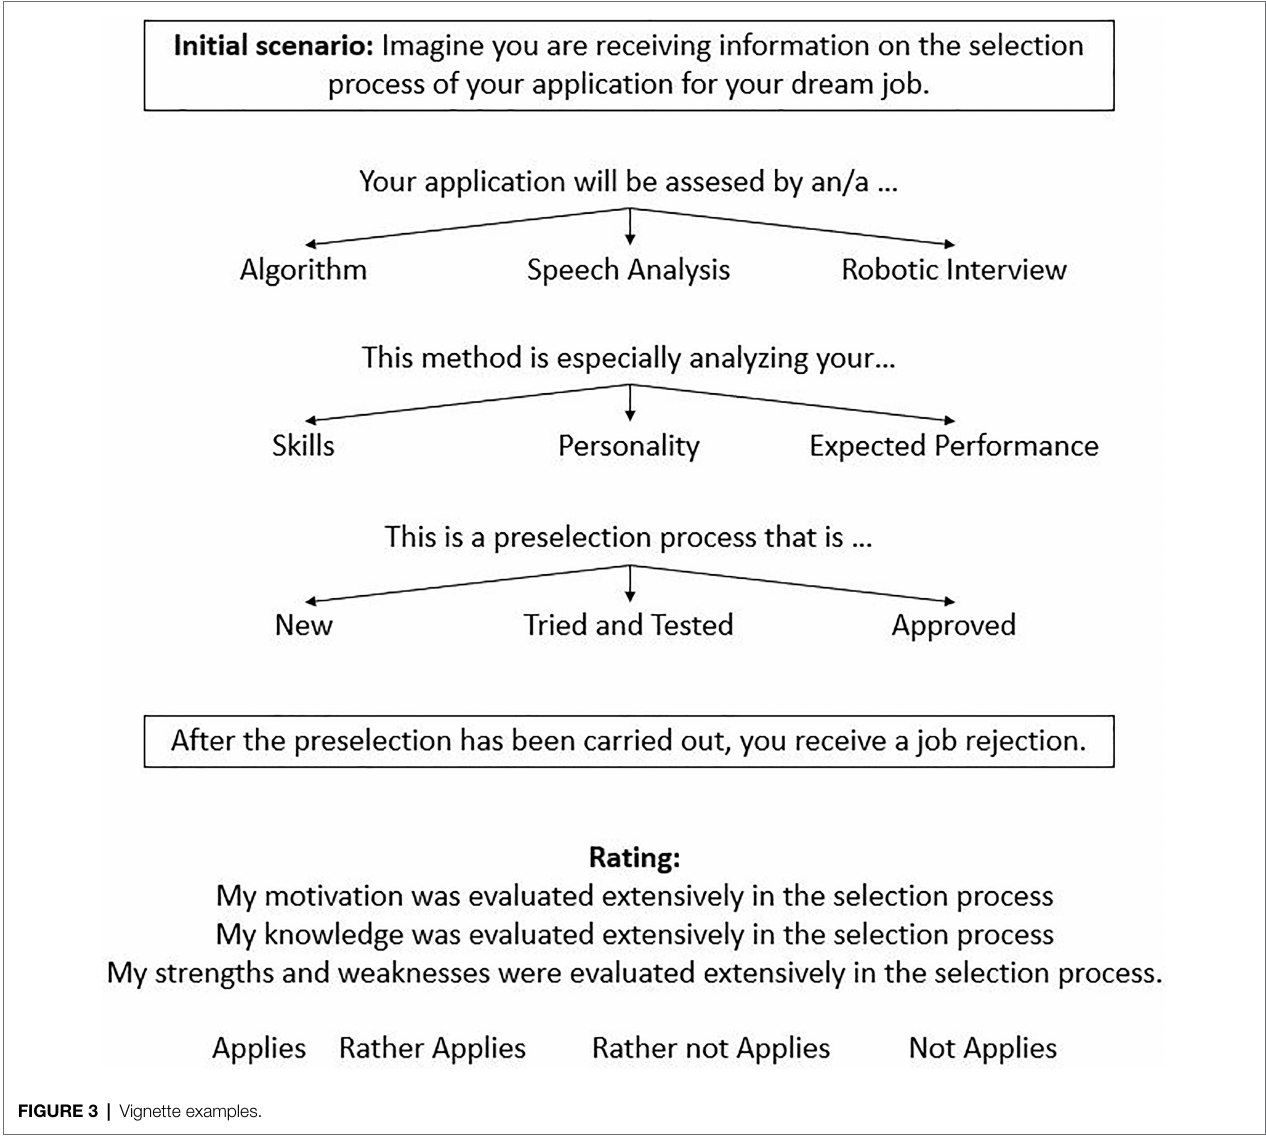
FIGURE 3 | Vignette